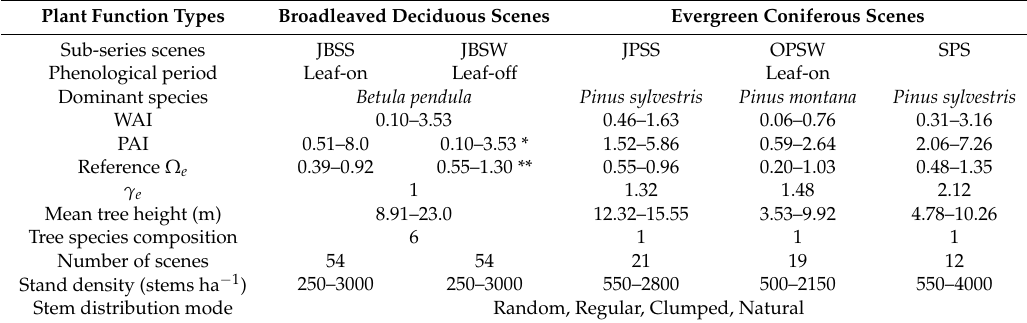
Ω e : canopy element clumping index, and γ e : needle-to-shoot area